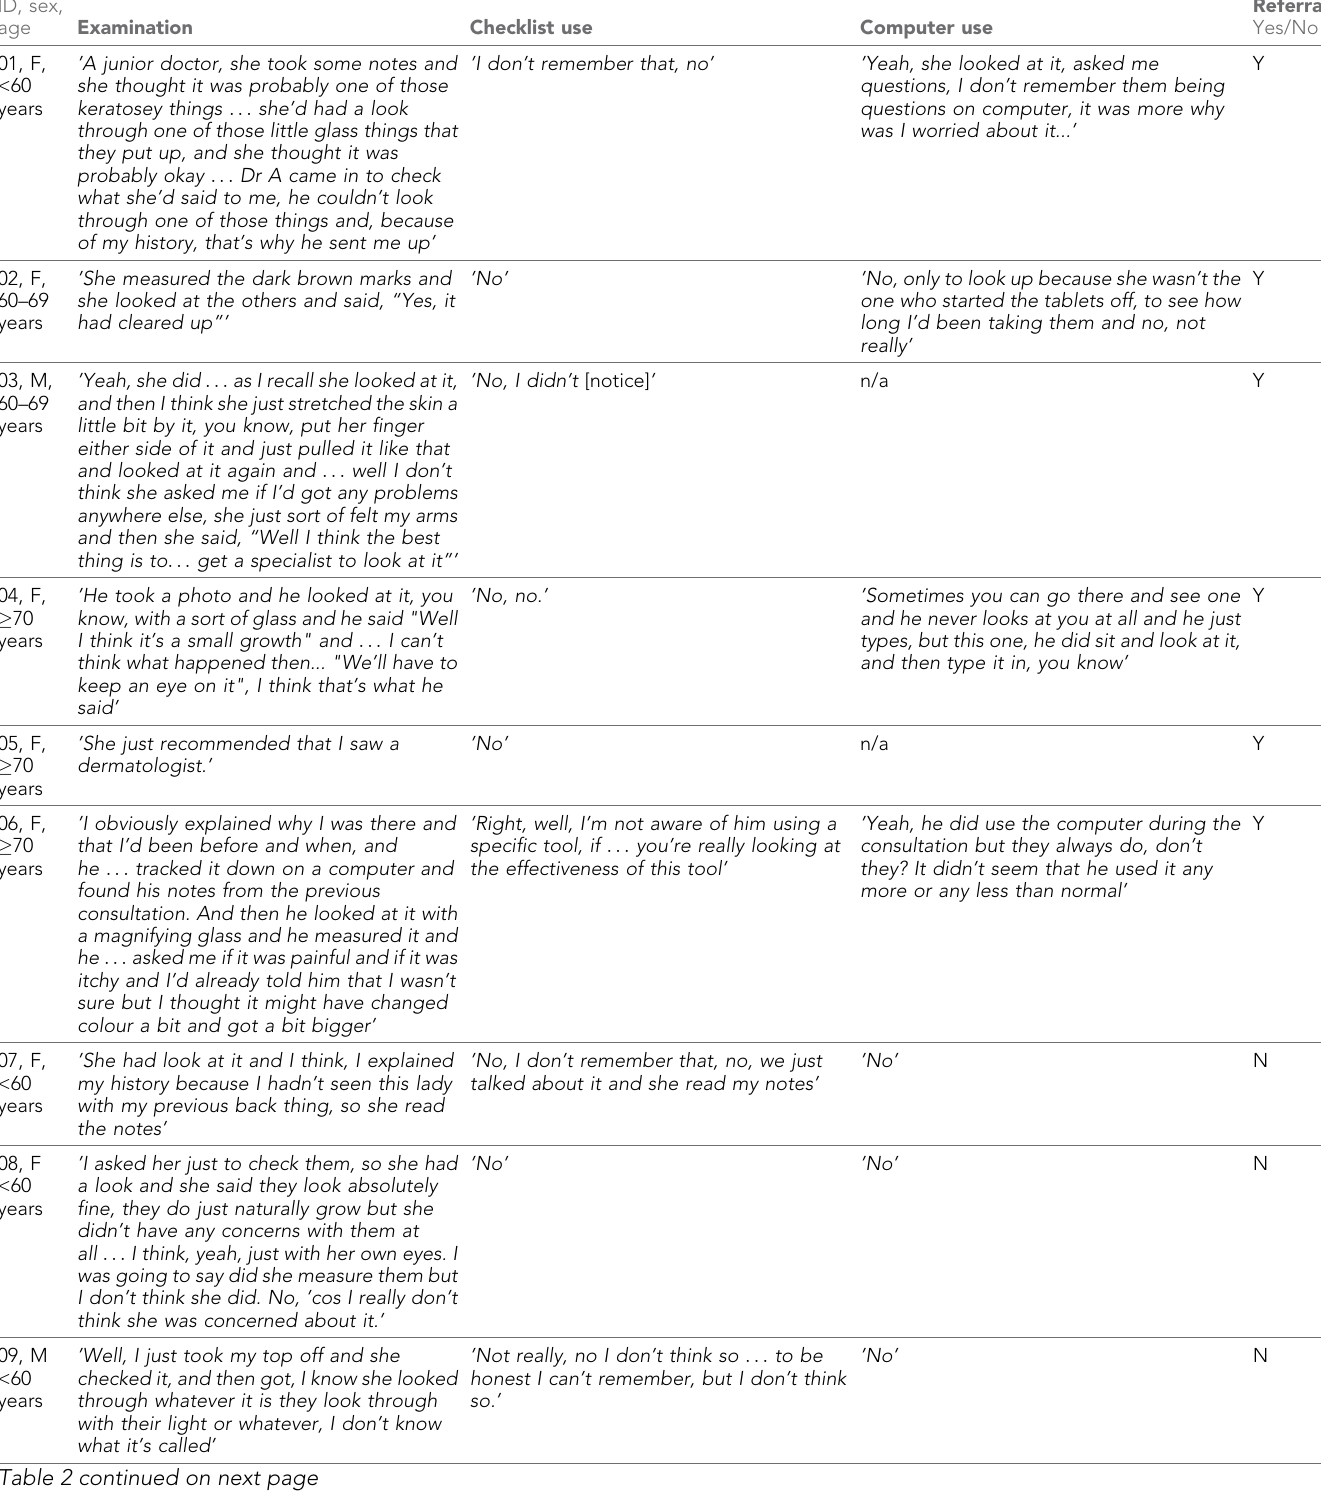
Table 2. Illustrative quotations from each patient about their consultation, including whether they were examined, whether a checklist or computer tool was used, and whether they were